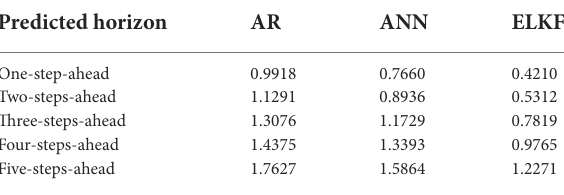
TABLE 1 Comparison of RMSE values (m/s) associated with values predicted by AR, ANN, and ELKF. Predicted horizon AR